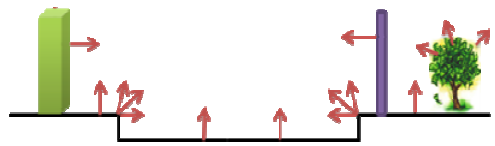
Figure 4. Surface normal direction for a road cross section.